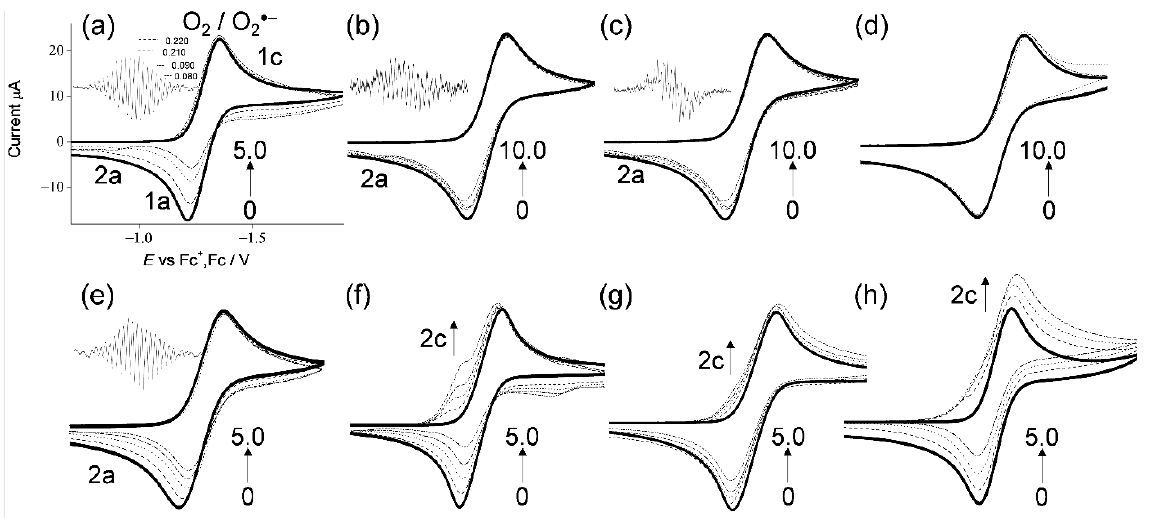
Figure 2. CVs of 4.8 × 10 − 3 mol dm − 3 O 2 in the presence of ( a – d ) α -, β -, γ -, and δ -TOH, ( e ) 2,2,5,7,8-pentamethyl-6-chromanol, ( f ) homogentisic acid γ -lactone, ( g ) 2,3-dihydro-2,2-dimethyl-7-hydroxybenzofuran, and ( h ) trans- para -coumaric acid, in DMF containing 0.1 mol dm − 3 TPAP recorded with a GC electrode at a scan rate of 0.1 V s − 1 . Concentrations (×10 − 3 mol dm − 3 ) are 0 (bold line), 1.0, 2.0, 3.0, and 5.0 ( a , e – h ), and 0 (bold line), 1.0, 2.0, 3.0, 5.0, and 10.0 ( b – d ) (the concentration changes are shown by arrows).